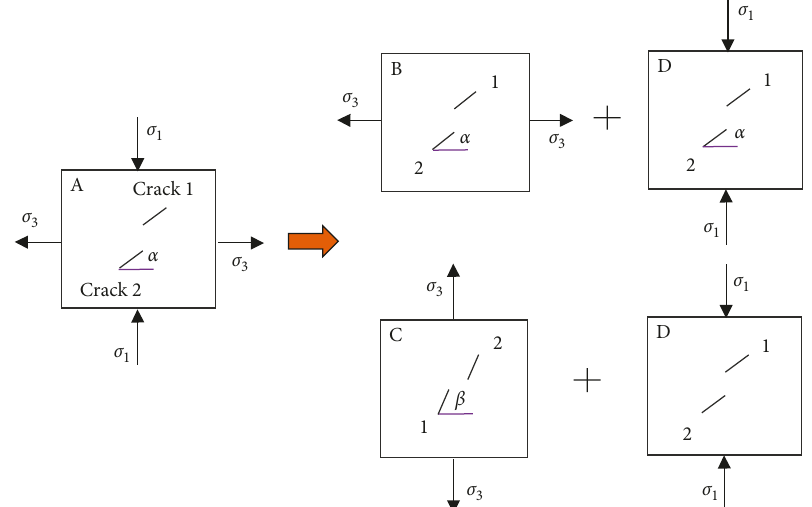
Figure 3: Superposition method of stress state of rock mass with double cracks under unloading conditions.